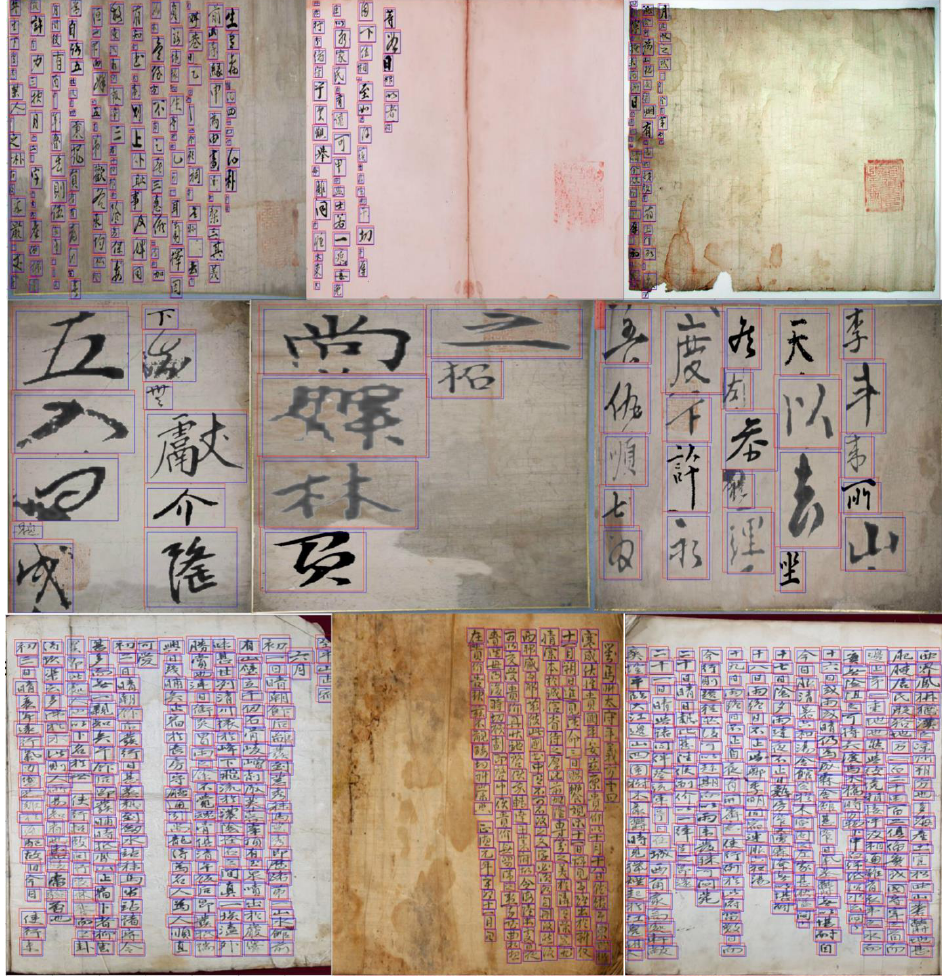
Figure 6. Detection examples on our benchmark using a merged dataset for generalization purposes. Our model is capable of finding multi-scale Chinese characters in historical manuscripts, and achieved extremely accurate results. Even it proved to have the ability to recognize backgrounds without detection errors.